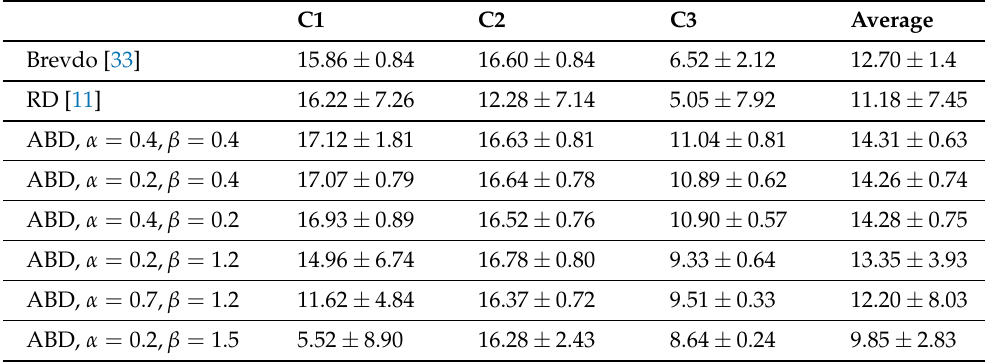
Figure 7. Amplitudes associated with components C1 ( left ), C2 ( middle ), and C3 ( right ). Table 1. RQF of each reconstructed components (averaged over 100 realizations of noise) for the different competing approaches for a SNR = 10 dB without AM. In second rows are displayed, for each case, the std of the estimators.